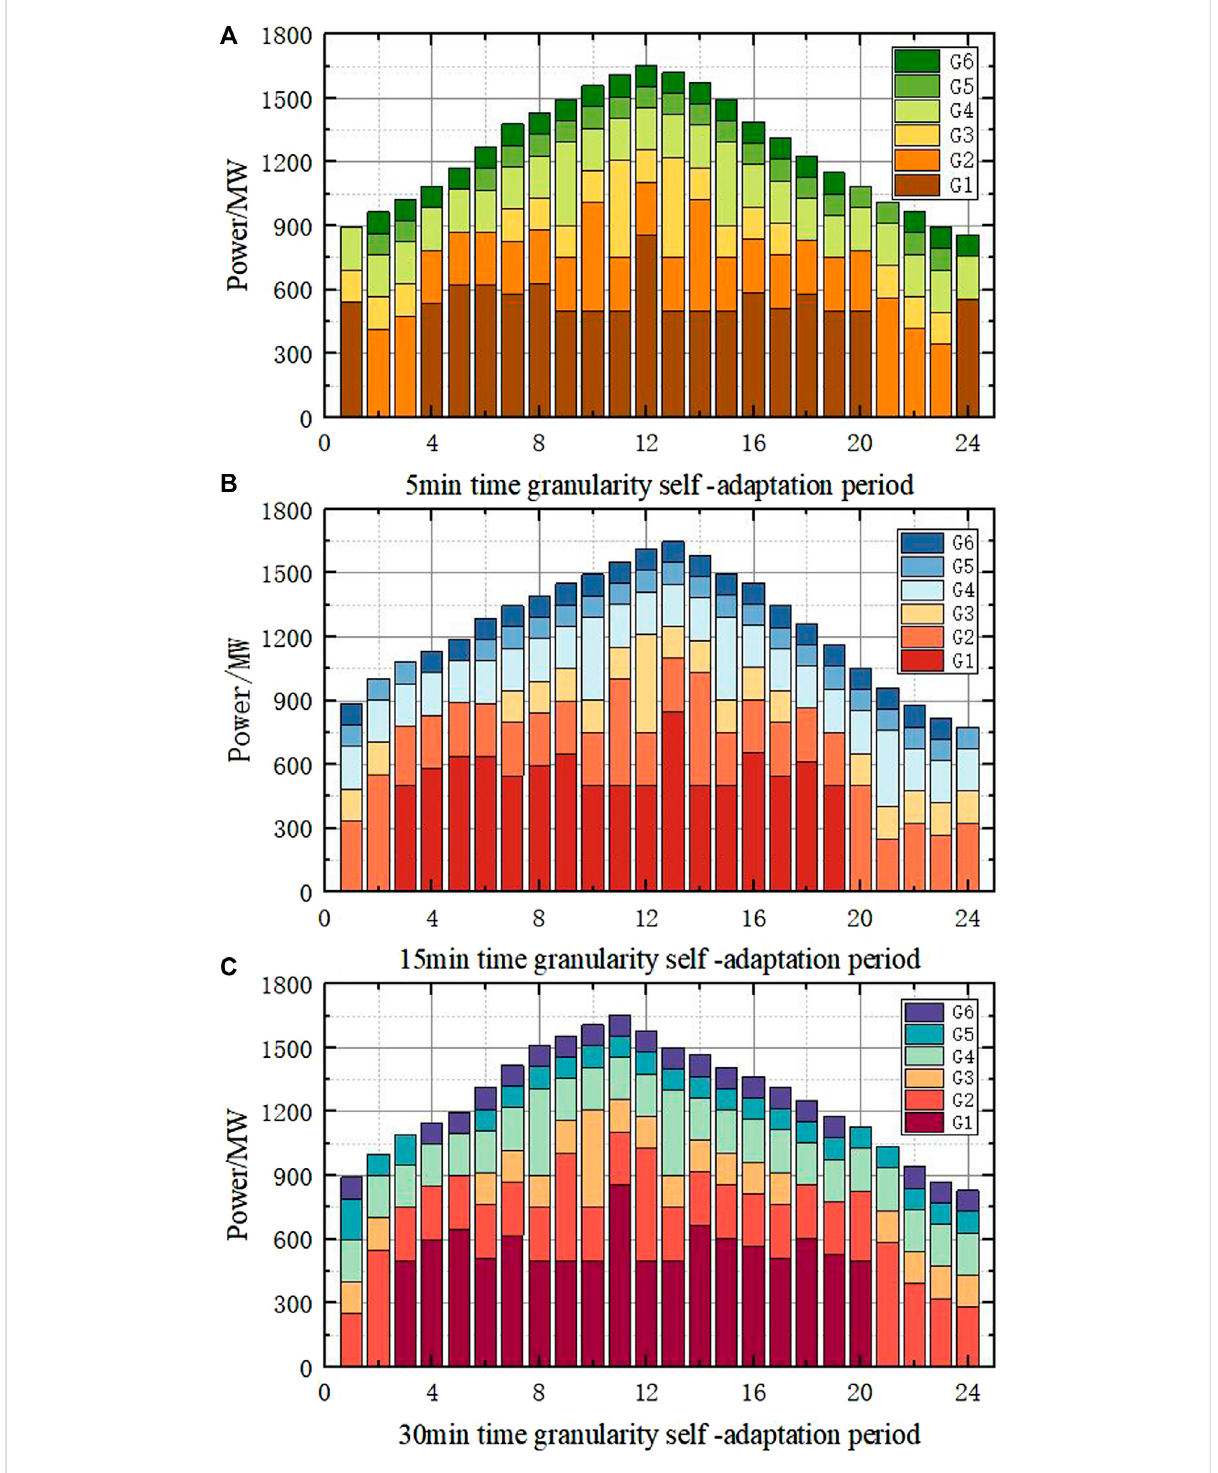
FIGURE 15 Output arrangement of the thermal power unit under different models. (A) Thermal power unit output at 5 min time granularity; (B) Thermal power unit output at 15 min time granularity; (C) Thermal power unit output at 30 min time